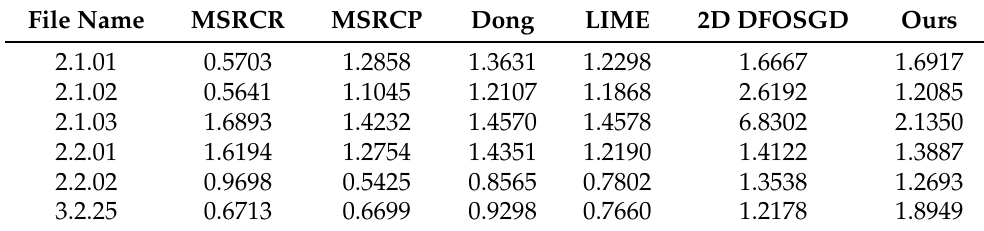
Table 4. The comparison of EMEE ( α = 0.5, L = 4).